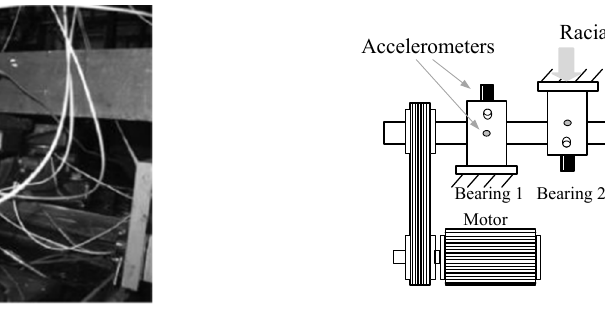
Figure 10. Cincinnati University bearing test bench.